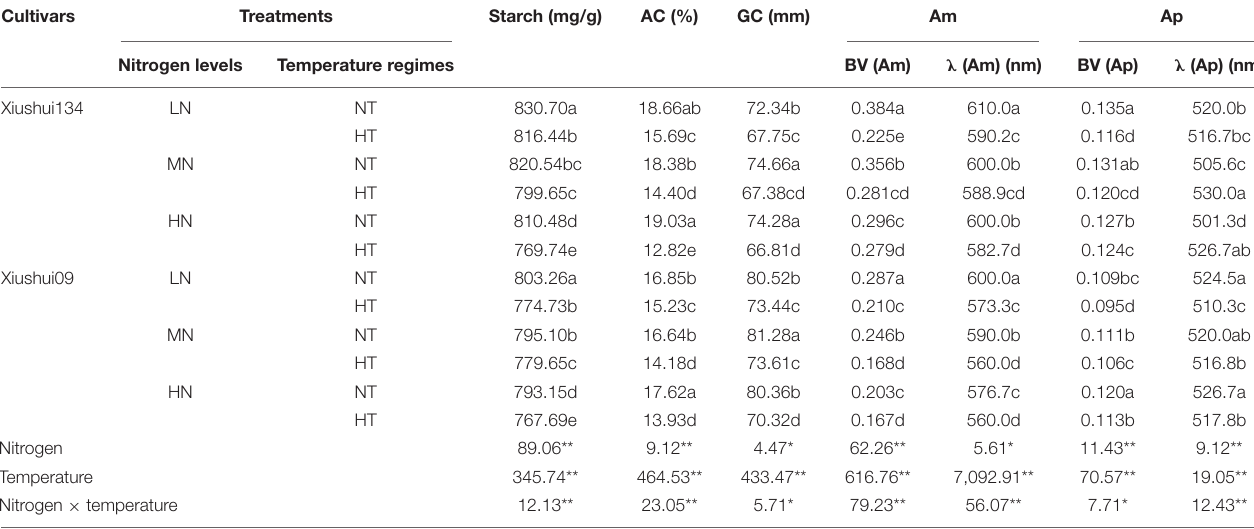
TABLE 3 | Difference in chemical component related to cooking and eating quality among different treatments. Cultivars